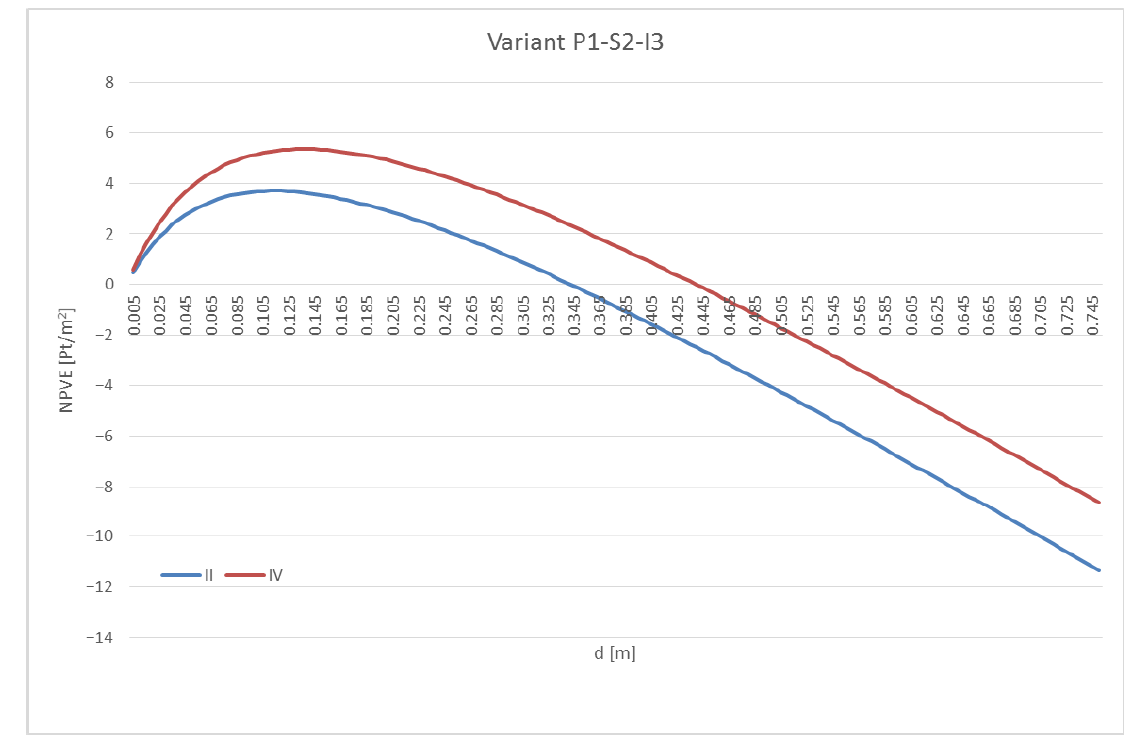
Figure 6. NPV E values depending on the thickness of thermal insulation for variant P1-S2-I3 in zones II and IV.